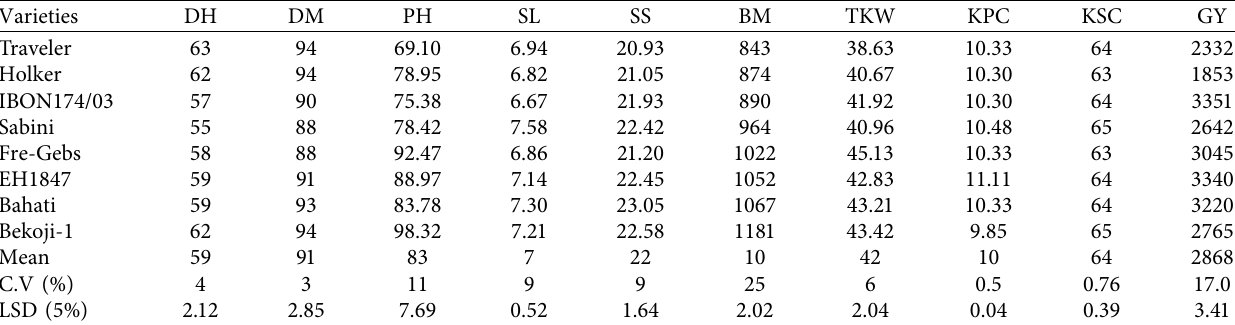
Table 3: Mean values of agronomic, yield, and quality traits of malting barley varieties tested at four environments (two locations in two years).